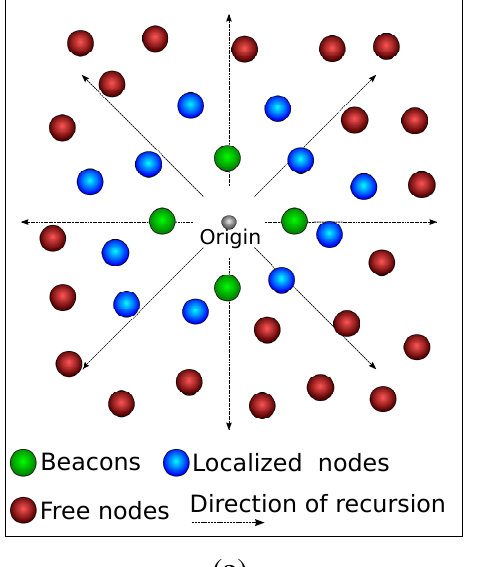
Figure 2. Stages of the Directed Position Estimation. ( a ) DPE Overview; ( b ) Trilateration with